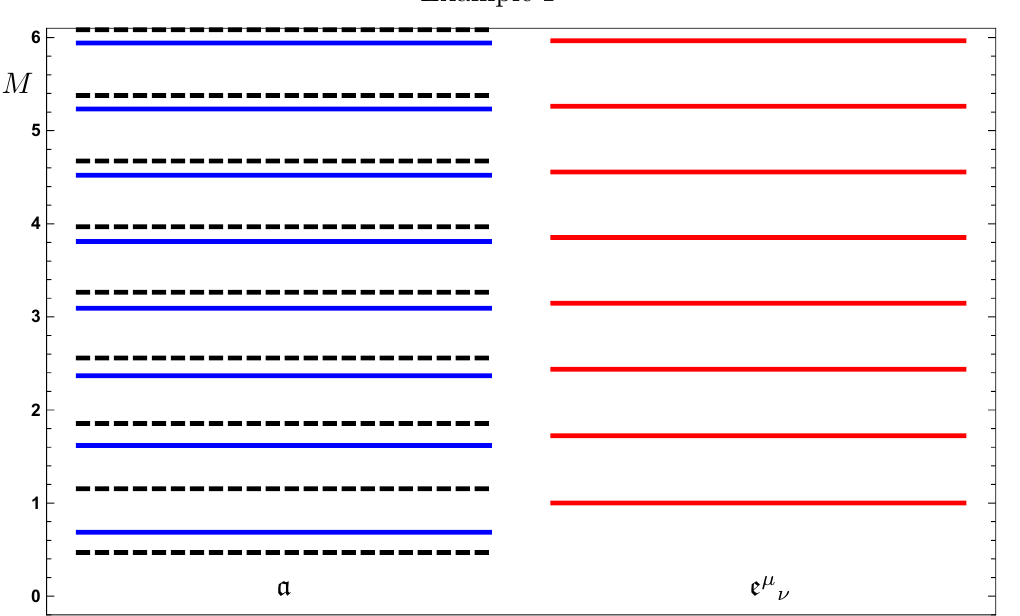
Figure 7 . The spectrum of scalar a (left, blue) and tensor e (cid:22) (cid:23) (right, red) (cid:13)uctuations in the holographic model de(cid:12)ned by the regular background solution of circle compacti(cid:12)cation of the AdS 5 (cid:2) S 5 system. All masses are expressed in units of the lightest tensor. In the calculation of the spectrum we use the cuto(cid:11)s (cid:26) 1 = 10 (cid:0) 6 and (cid:26) 2 = 8. The black (long-dashed) spectrum illustrates the result of the probe approximation for the